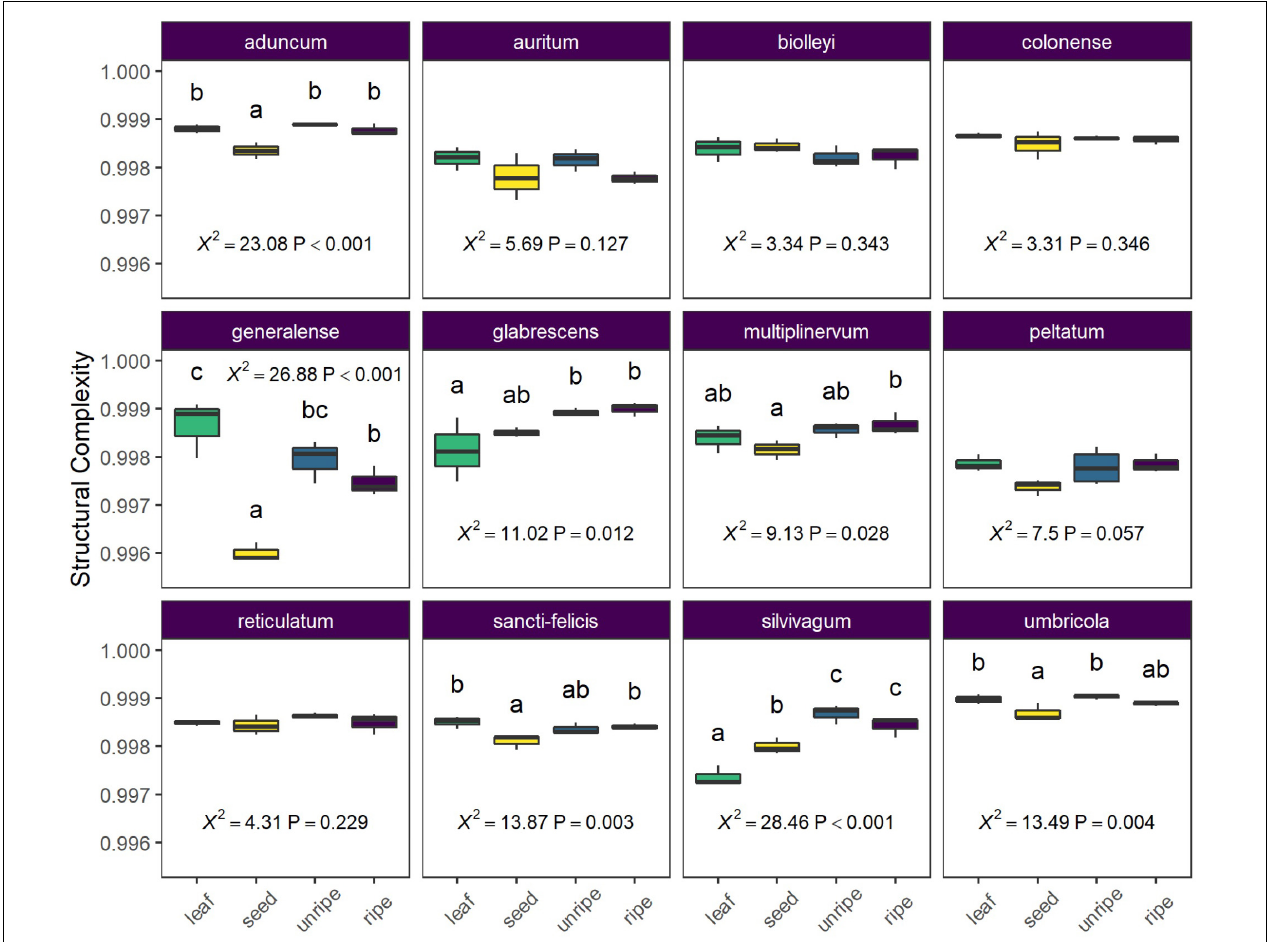
FIGURE 5 | Average structural complexity differs across species and organ type (leaf, seed, unripe pulp, and ripe pulp). Letters above each box plot column indicate results of pairwise Tukey post-hoc comparisons of organs within each species, with non-shared letters indicating a significant difference at P < 0.05. Each species plot includes χ 2 and P -values from species-level